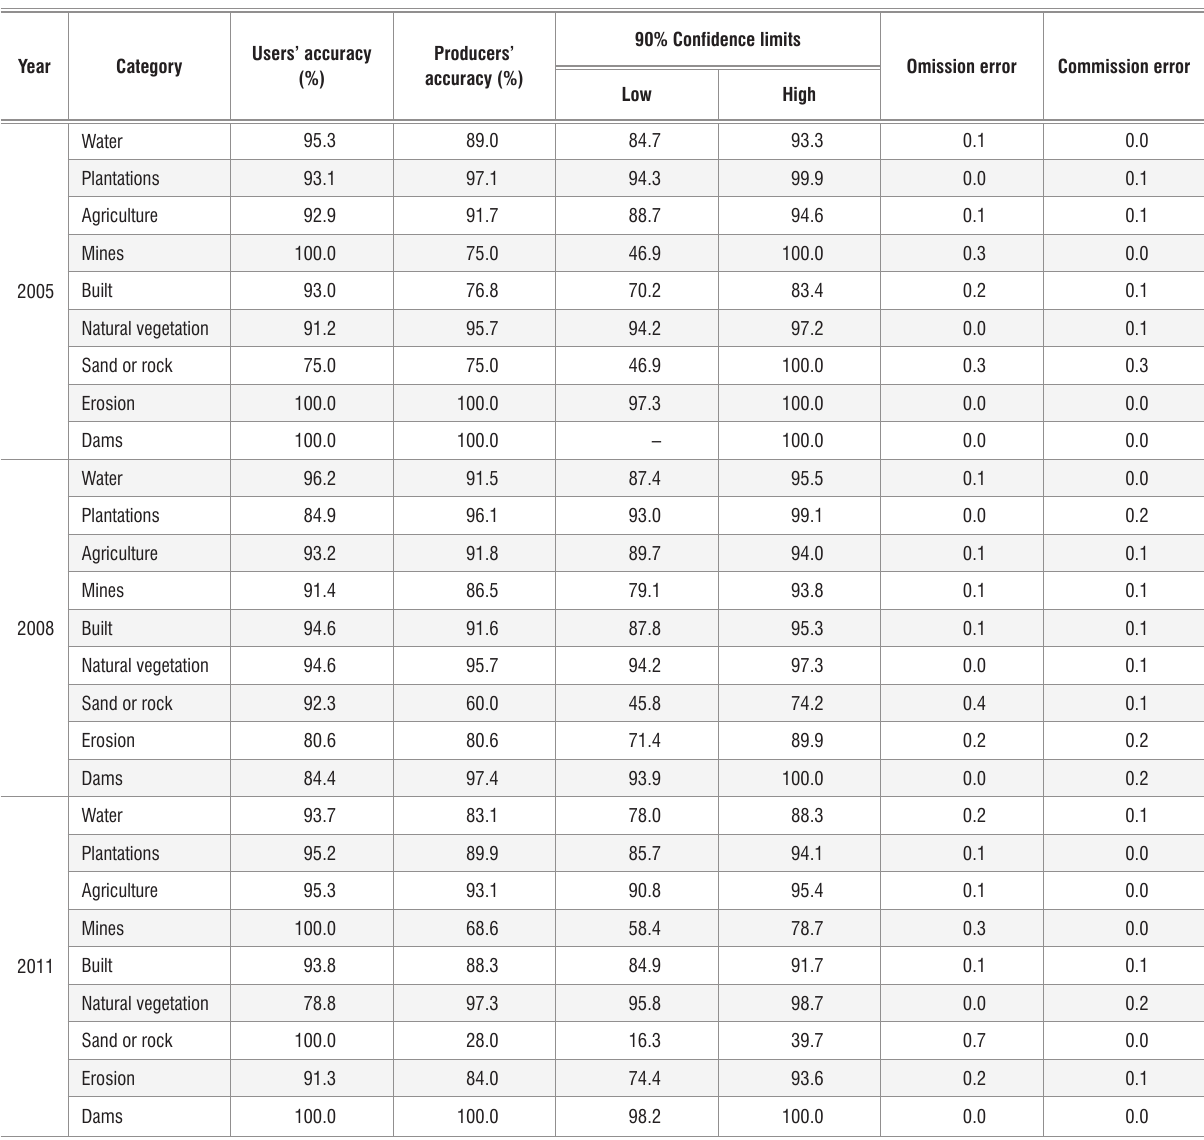
Table 3: Aggregated class accuracy statistics for the KwaZulu-Natal 2005, 2008 and 2011 land-cover maps